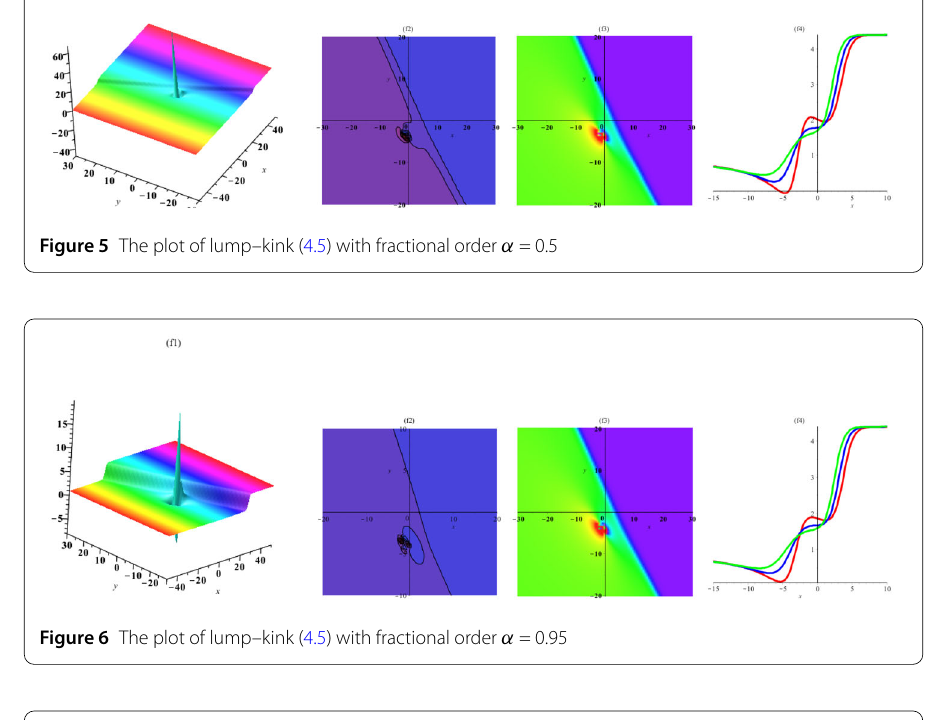
Figure 7 The 2D plot of lump–kink (4.5) with the different fractional